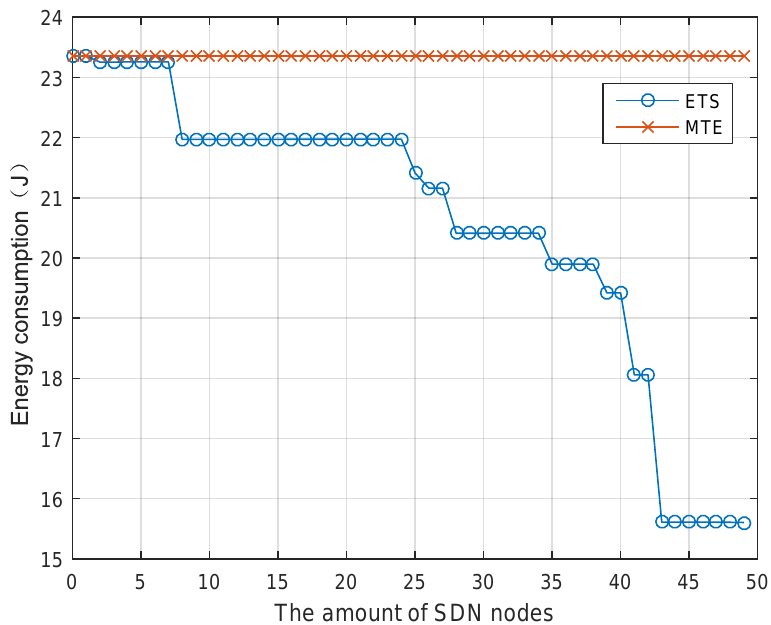
Figure 4. Energy consumption with different SDN nodes.